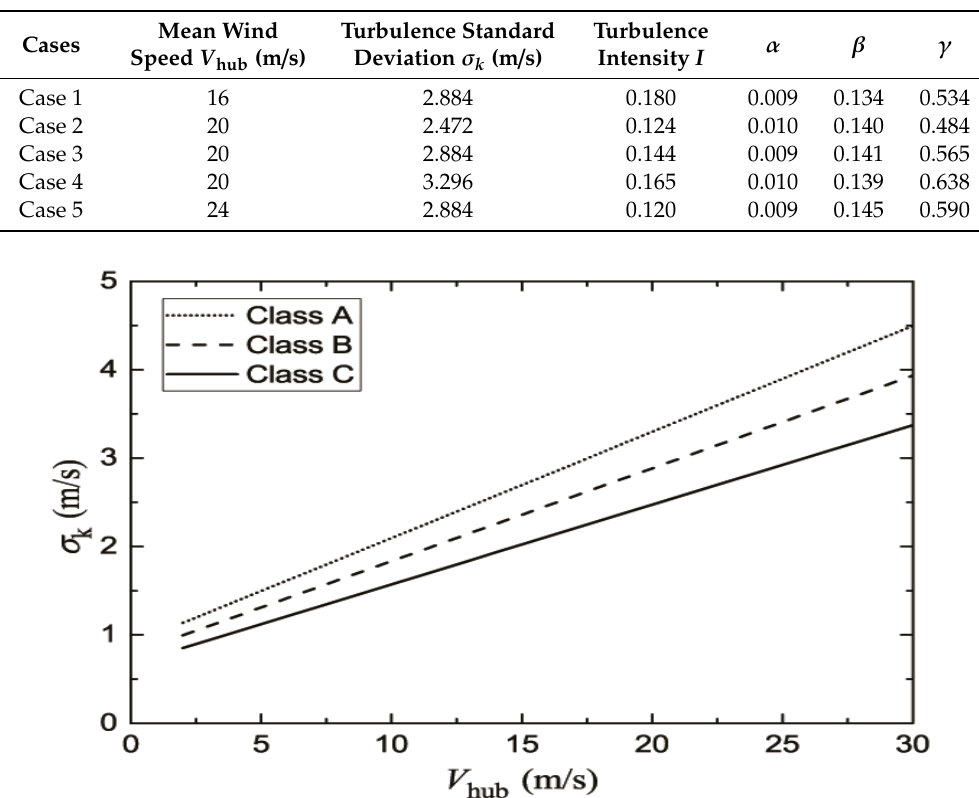
Figure 7. Wind excitation spectrum for the wind condition of Case 3 and transfer function (TRF) for the NREL 3 MW wind turbine.